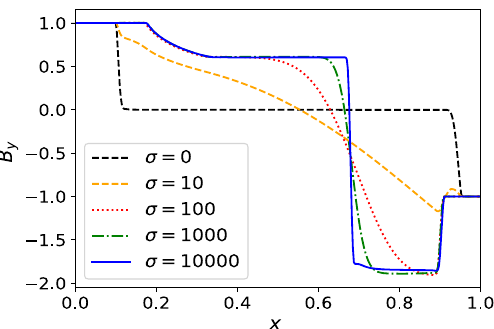
Fig. 1 We display the magnetic field B y at t = 0 . 4 in the Brio–Wu type shock tube test